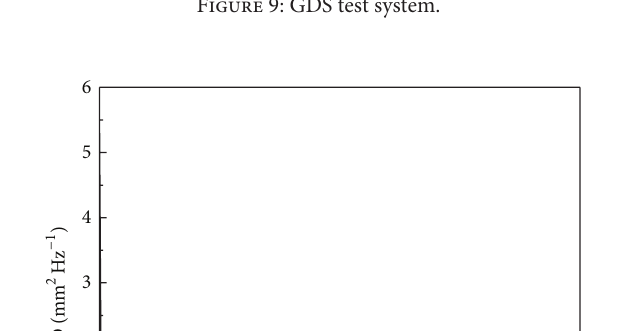
Figure 9: GDS test system.